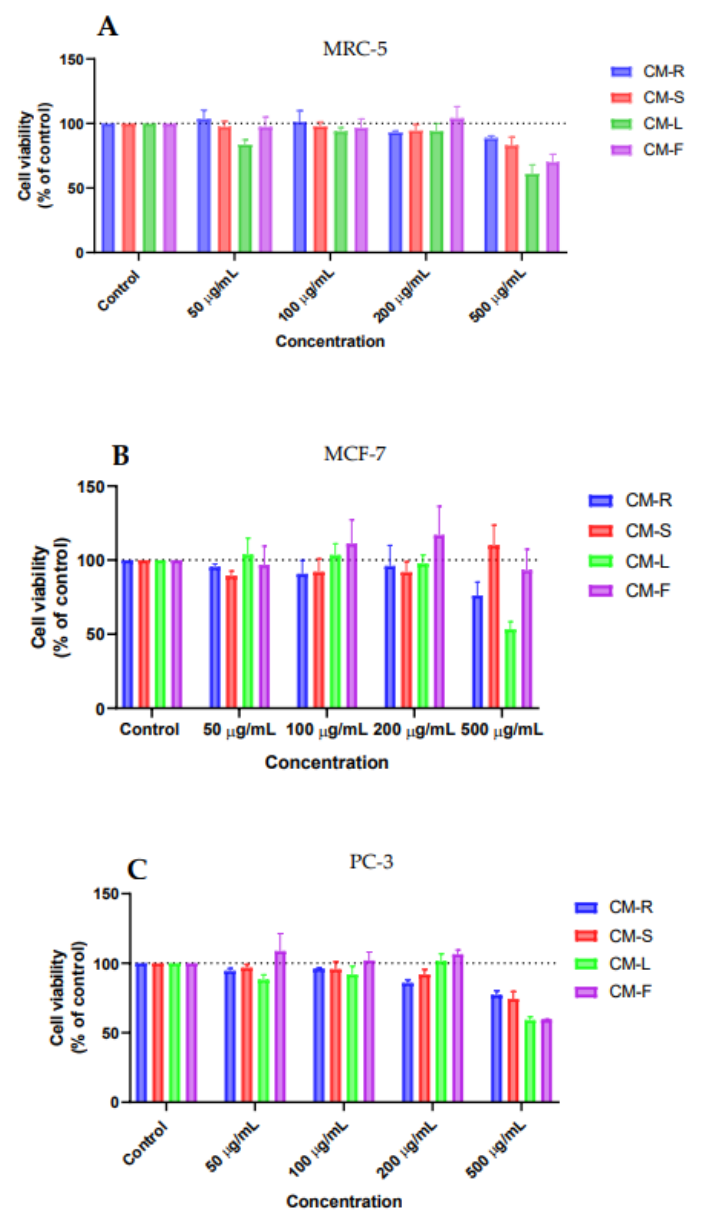
Figure 7. Comparative biosafety evaluation of the antitumor activity of Cladanthus mixtus extracts on cancer cells after 48 h of treatment. ( A ): MRC-5, ( B ): MCF-7, ( C ): PC-3.